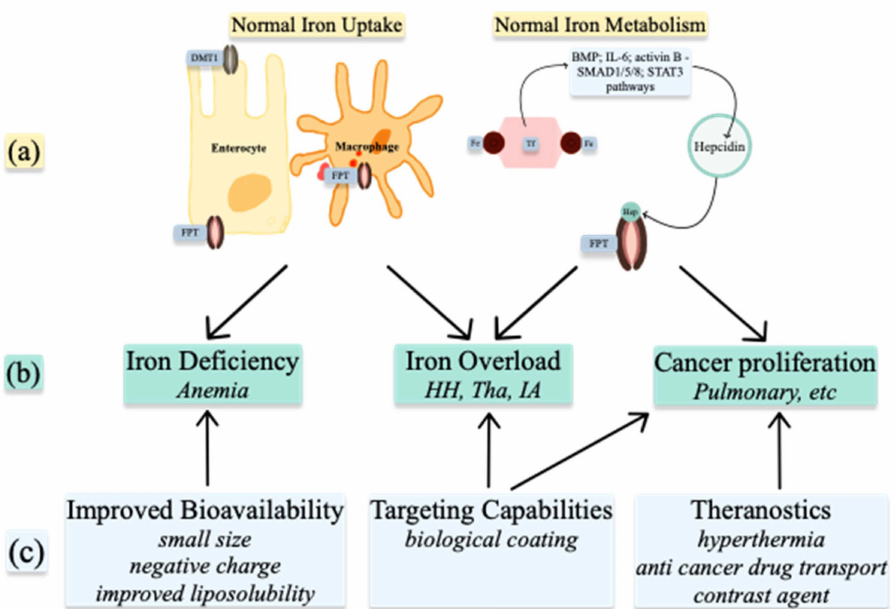
Figure 5. Medical uses of Iron nanoparticles: ( a ) normal Iron homeostasis; ( b ) pathologies resulting from abnormal Iron homeostasis; ( c ) properties of nanoparticles. DMT1—divalent metal transporter 1; FPT—ferroportin; Fe—iron; Hep—hepcidin; BMP—bone morphogenic protein; IL-6—interleukin 6; HH—hemochromatosis; Tha—Thalassemia; IA—inflammatory